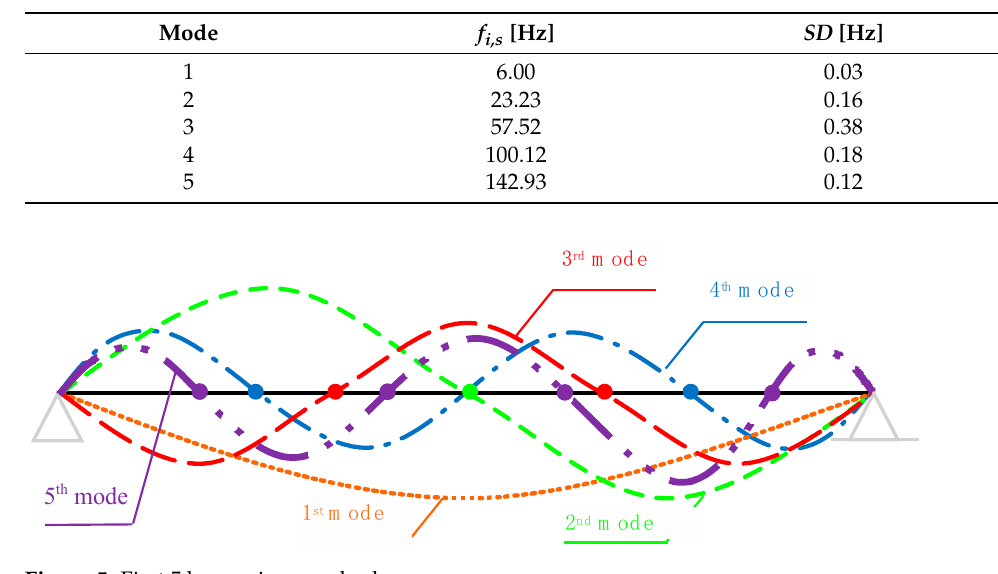
Table 3. Experimental eigenfrequencies of the simply supported beam and the corresponding standard deviation (SD).